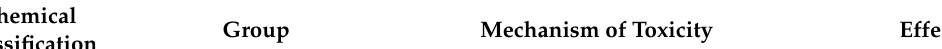
Table 1. Mechanism of toxicity of